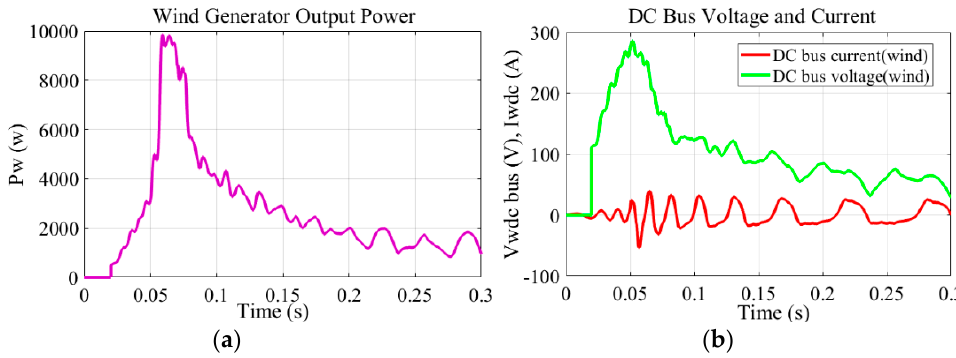
Figure 10. ( a ) Power output of wind turbine. ( b ) DC bus voltage and current from wind source.